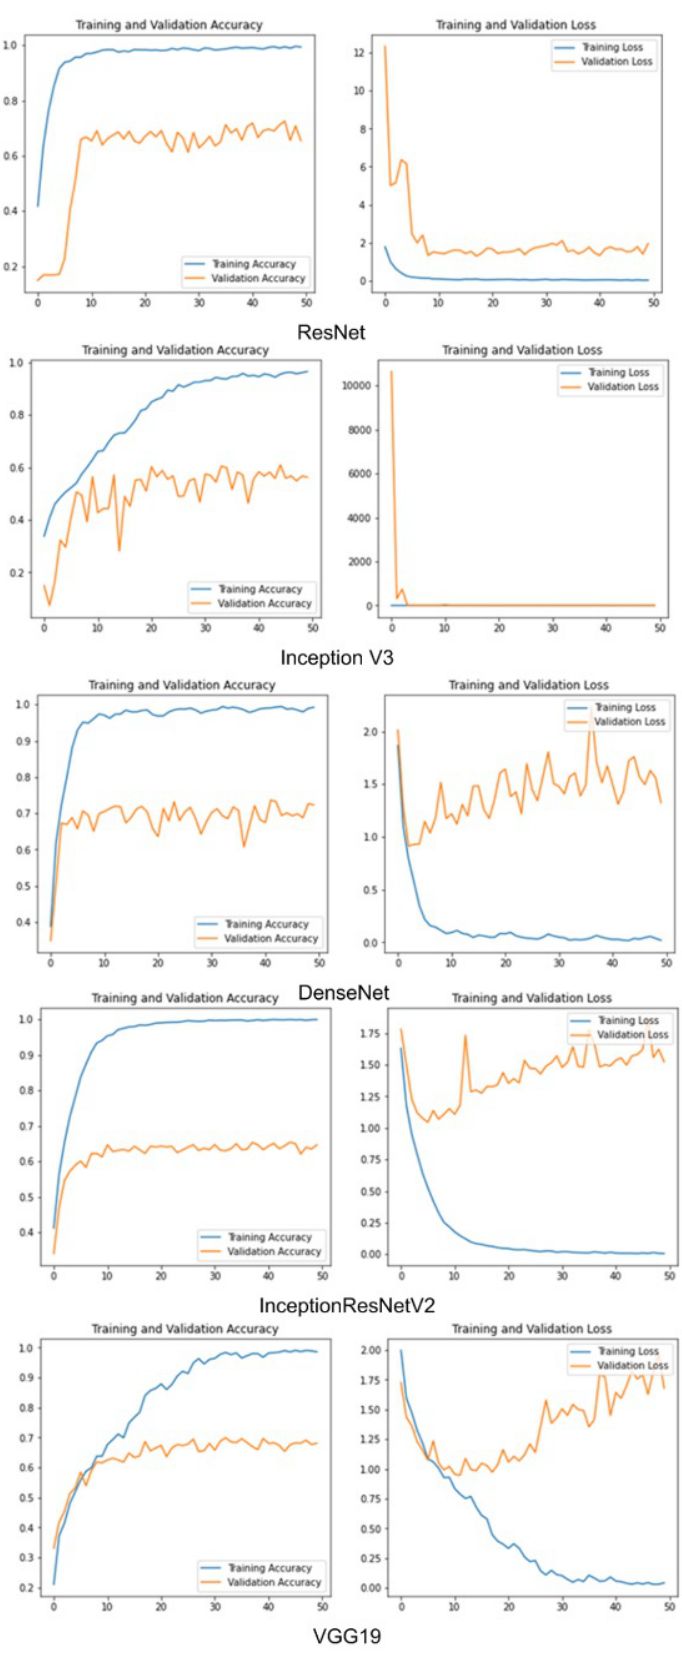
Figure 6. Training and validation accuracy vs.